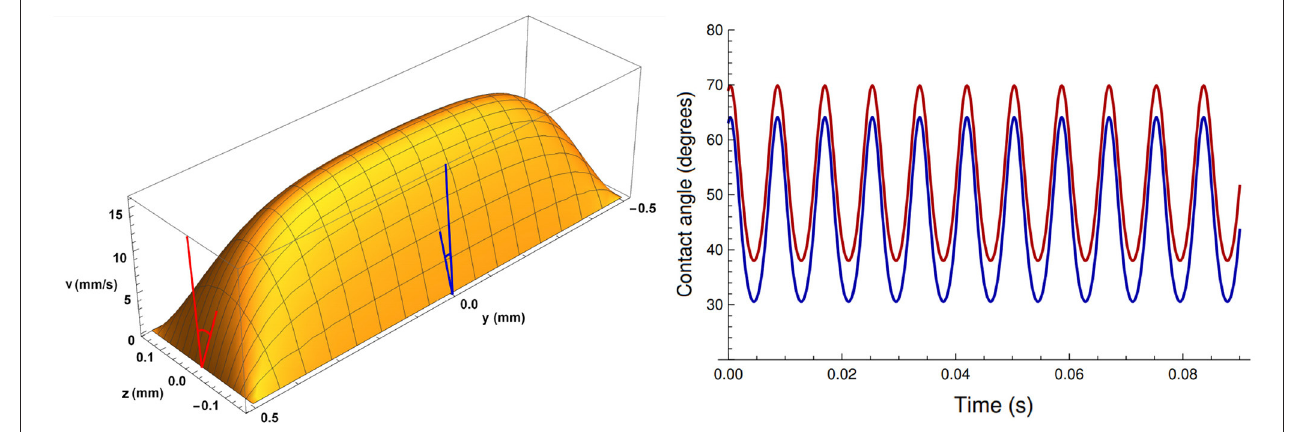
FIGURE 11 | Left : Illustration of an instantaneous velocity profile in a cross section of a rectangular microchannel, computed theoretically following [63]. Right : Illustration of the time behavior of the angle (given by the arctan of the slope) along the channel width (red), and along the channel height (blue), for a channel whose width is three times its height.